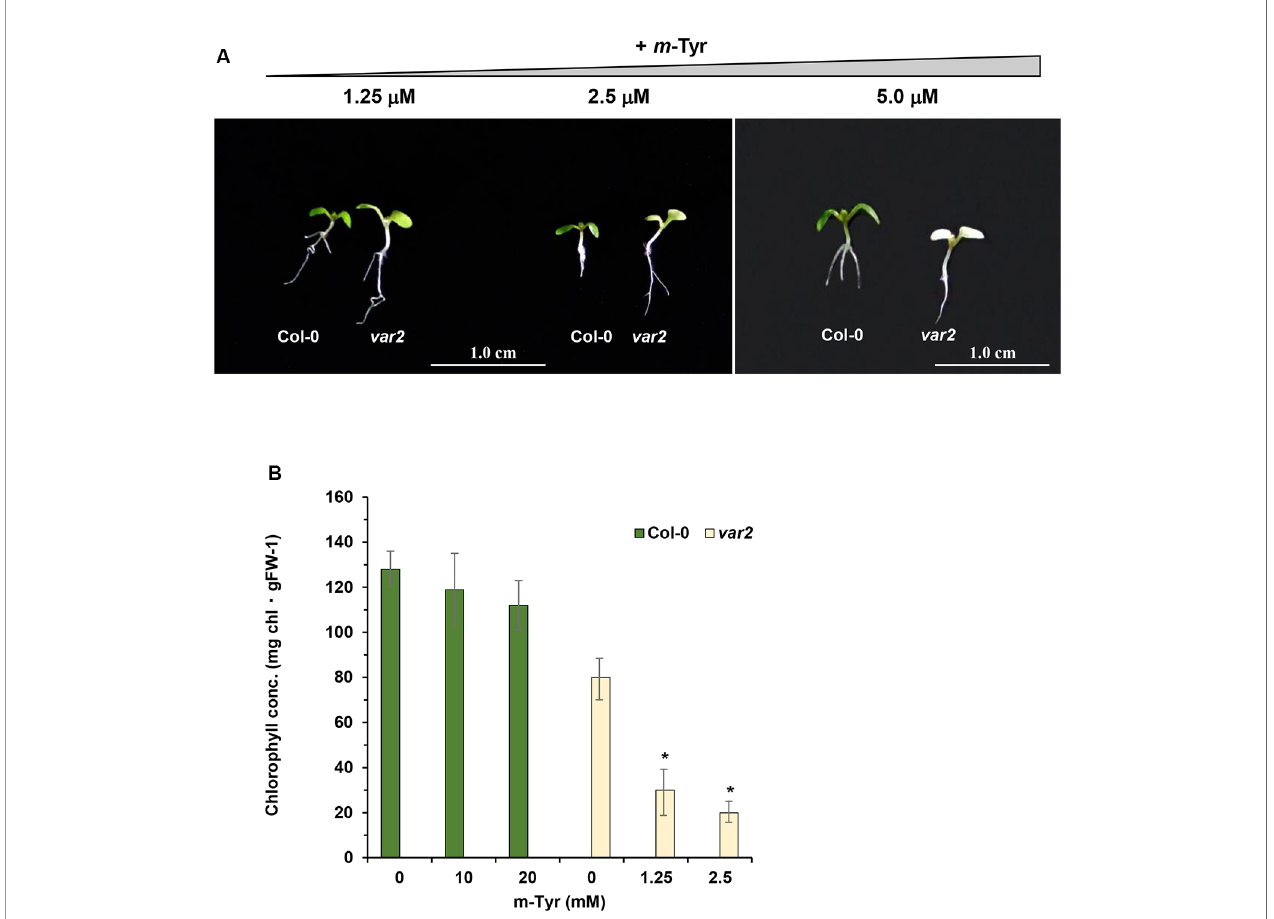
FIGURE 7 | The effect of m -tyrosine on Arabidopsis wild-type (Col-0) and var2 knockout mutant-line. (A) Seeds of Arabidopsis wild-type (Col-0) and homozygous var2 mutant-line (Takechi et al., 2000; Sakamoto et al., 2003; Zaltsman et al., 2005) (generously provided by the group of Prof. Zach Adam, The Hebrew University) were germinated in Murashige and Skoog (MS)-agar plates in the absence or presence of different concentration of m -tyrosine. The values are means of three biological replicates with about 25 seedlings, as indicated in the panel. The fi gure shows 5-day-old seedlings. Bars represent 1 cm in each panel. The values are means of three biological replicates with about 25 seedlings (i.e., 5-day-old). Error bars indicate one standard deviation. Asterisk in (panel B ) indicates a signi fi cant difference from var2 mutants control plants (Student's T-test, P ≤